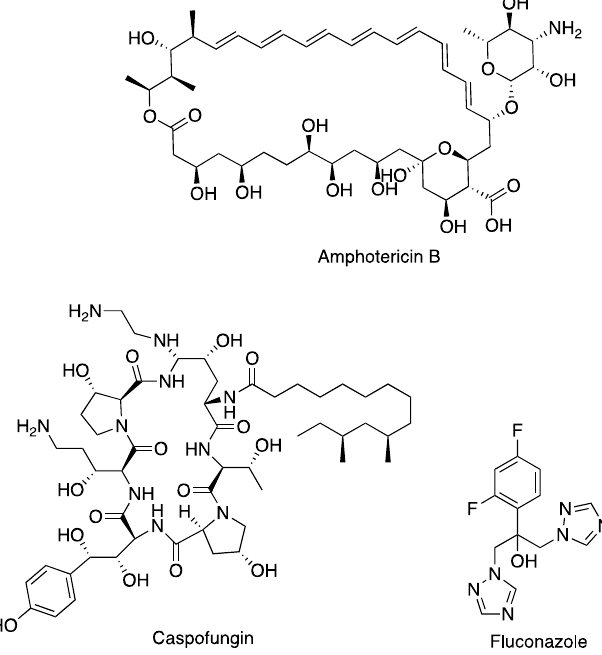
Figure 1. Chemical structure of representatives of the three classes of antifungal drugs used in the treatment of invasive fungal infections: amphotericin B (polyene), caspofungin (echinocandin), and fluconazole (azole).